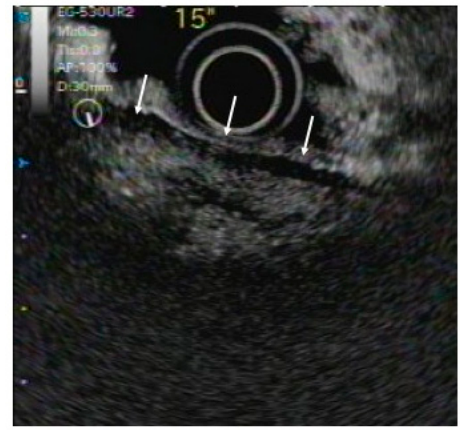
Figure 3. Contrast-enhanced harmonic EUS (CEH-EUS). CEH-EUS findings revealed hypervascular pancreatic enlargement surrounded by hypovascular lesions (capsule-like rim) (arrow).